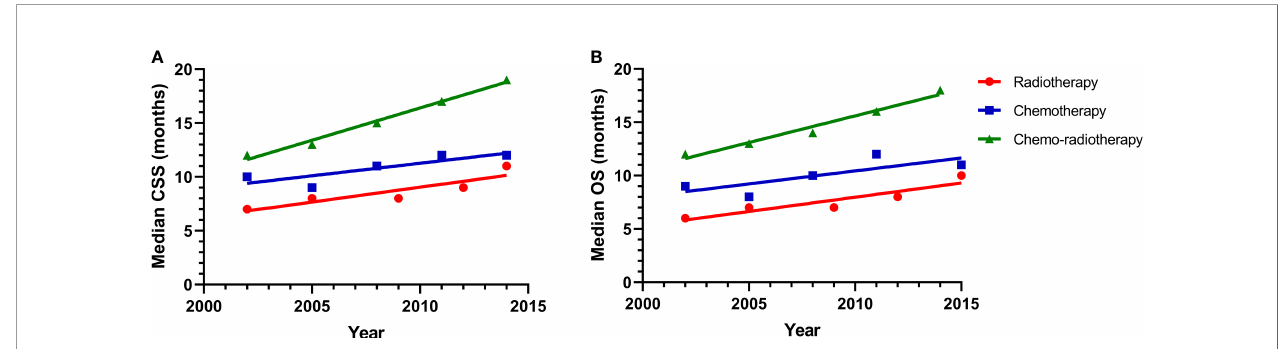
FIGURE 2 | (A) A linear regression model for median survival of CSS in the radiotherapy alone (r = 0.8032, P = 0.0395), chemotherapy alone (r = 0.7206, P = 0.0689), and chemo-radiotherapy groups (r = 0.9878, P = 0.0006); (B) A linear regression model for median survival of OS in the radiotherapy alone (r = 0.8487, P = 0.0262), chemotherapy alone (r = 0.6080, P = 0.1199), and chemo-radiotherapy groups (r = 0.9868, P = 0.0022).